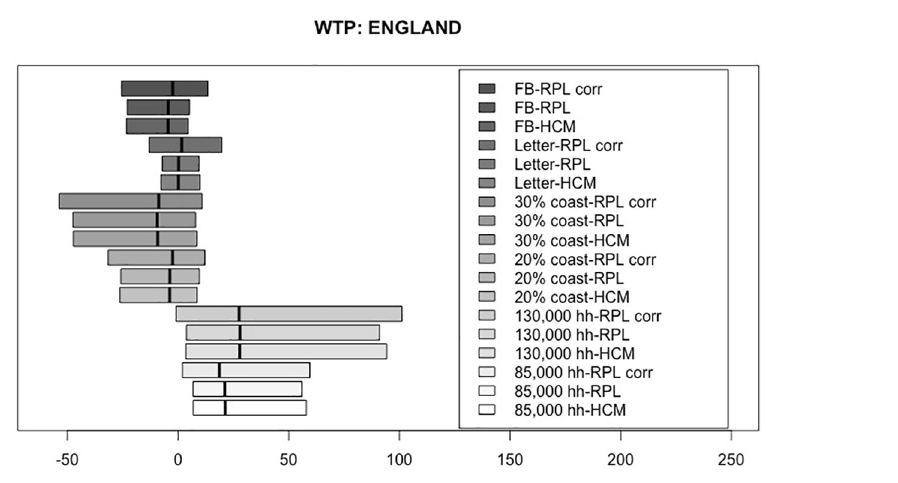
Fig 2. Distribution of WTP measures for